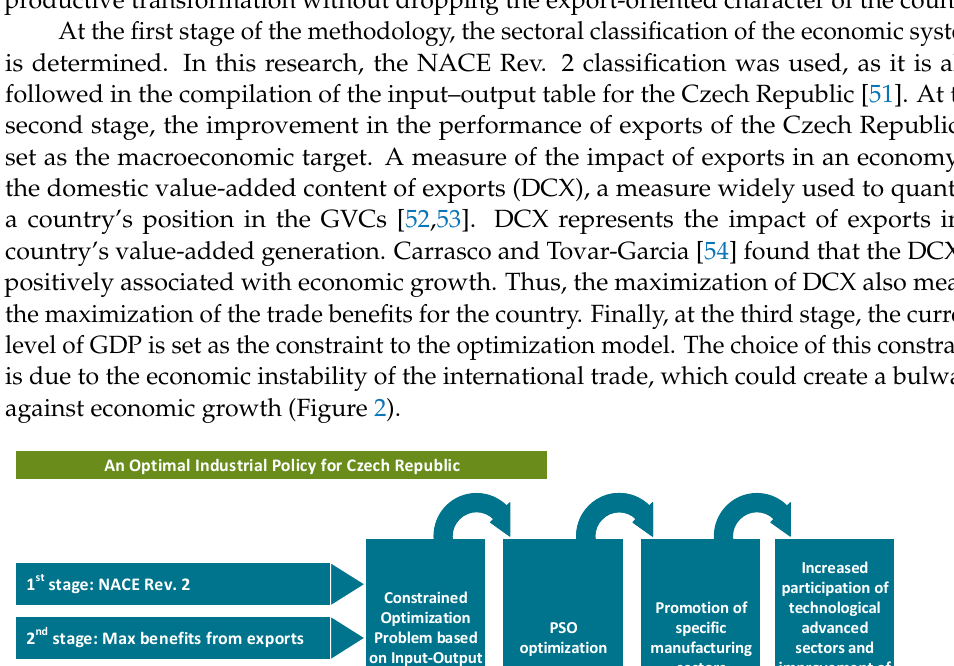
Figure 1. A graphical presentation of the methodological approach.